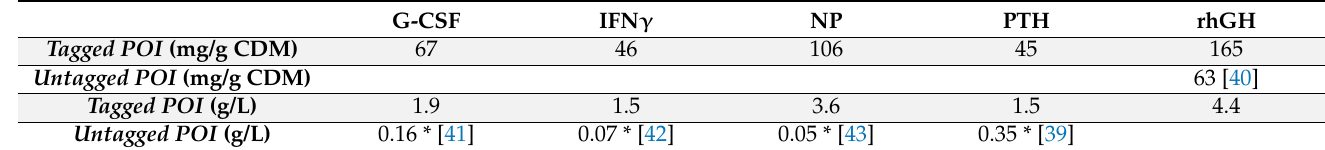
Table 1. Expression of POIs with and without CASPON-tag. Values for untagged POIs are taken from the literature. Soluble end titres of tested fusion proteins are adjusted for the untagged POIs. The rows titled Untagged POI depict specific or volumetric E. coli fermentation titres reported in the literature. Values denoted with a star (*) originate from shaker flask cultures and were in case of PTH corrected for the untagged protein content as it was expressed by Fu et al. as Trx-hPTH fusion protein [39]. G-CSF IFN γ NP PTH rhGH Tagged POI (mg/g CDM) 67 46 106 45 165 Untagged POI (mg/g CDM) 63